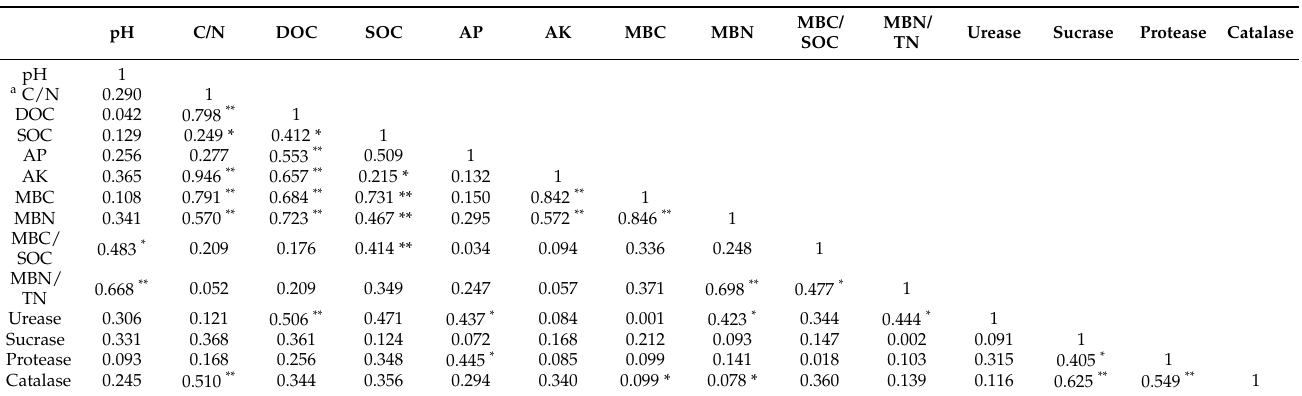
Table 4. Pearson’s correlation of the soil pH, soil nutrients, soil enzymatic activity, and soil microbial biomass dynamics at three soil depths along the forest stands in northeastern Hunan province, central south China.